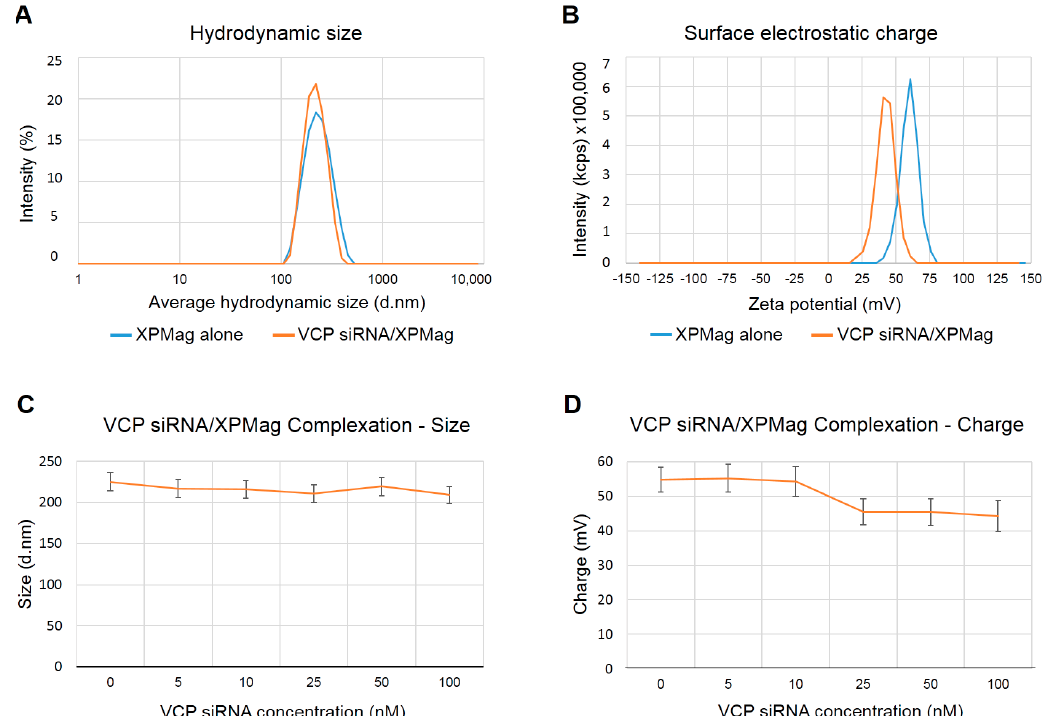
Figure 1. Characterization of valosin-containing protein (VCP) siRNA/XPMag complexation. ( A ) Hydrodynamic size distribution of XPMag alone (blue line) and VCP siRNA (25 nM)/XPMag complexes (orange line) measured by dynamic light scattering technique. The addition of VCP siRNA to XPMag did not influence the average hydrodynamic size of XPMag nanoparticles after 30 min of complexation. The graphic shows the distribution of the percentage of particle’s intensities versus average hydrodynamic size in diameter (d.nm). Average values are reported on a logarithmic scale. ( B ) Surface electrostatic charge of XPMag alone (blue line) the complexed with VCP siRNA (orange line), measured by electrophoretic dynamic light scattering. The surface charge of XPMag shifted towards a lower value upon the addition of VCP siRNA (orange line) without alteration of the peak shape. The graphic shows the scattering intensity recorded in photons per second (kcps) versus voltage-dependent electrophoretic mobility (mV). ( C ) Effect of VCP siRNA concentration on XPMag hydrodynamic size after 30 min of MNPs-siRNA complexation. Complexes obtained with concentrations of VCP siRNA from 5 to 100 nM did not differ in their hydrodynamic size, error bars are standard deviation, n = 9. ( D ) Effect of VCP siRNA on XPMag electrostatic surface after 30 min of MNPs-siRNA complexation. XPMag electrostatic surface decreased as a function of VCP siRNA concentration. Error bars correspond to standard deviation, n = 30. Abbreviations: d. nm: Diameter. nanometer; kcps: kilo counts per second, mV: millivolts.